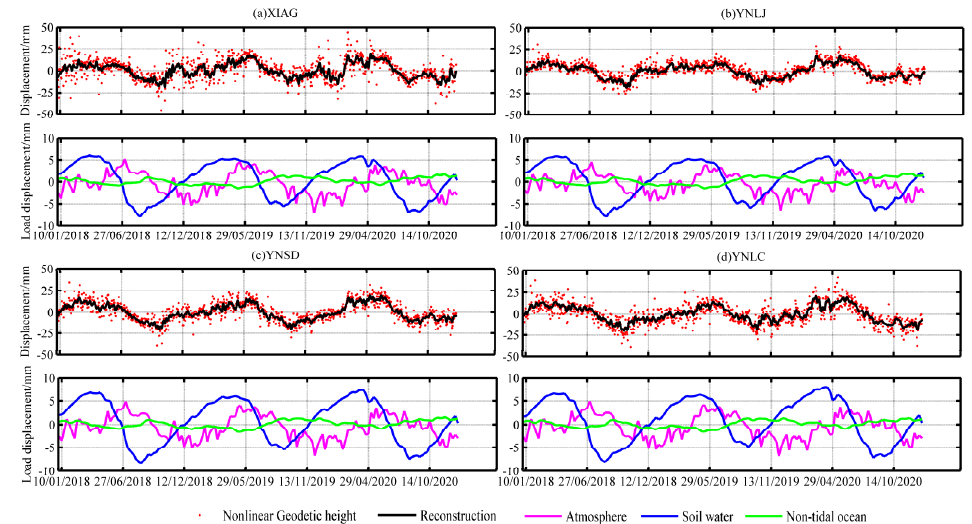
Figure 5. Processed geodetic height changes of different CORS stations and surface mass loads.